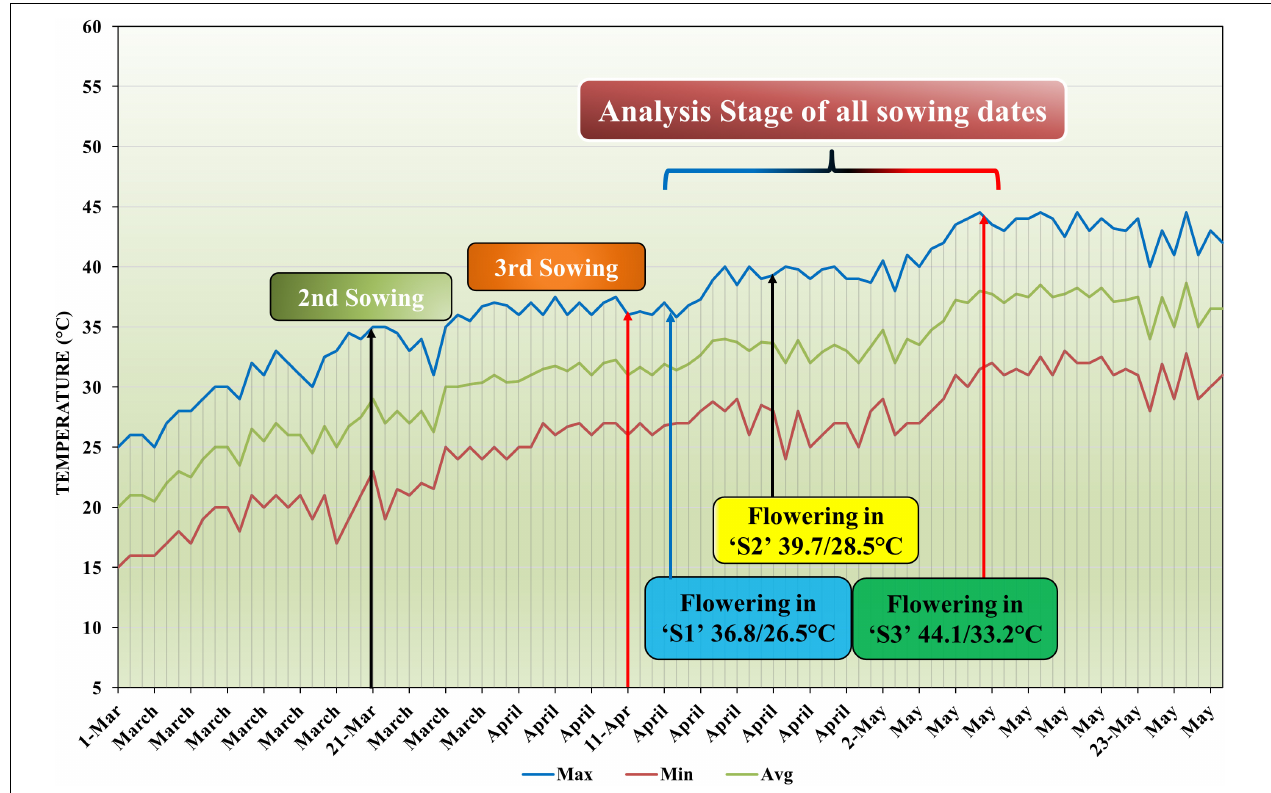
FIGURE 1 | Maximum, minimum, and average temperature profile during three sowing time situations in the growing season of